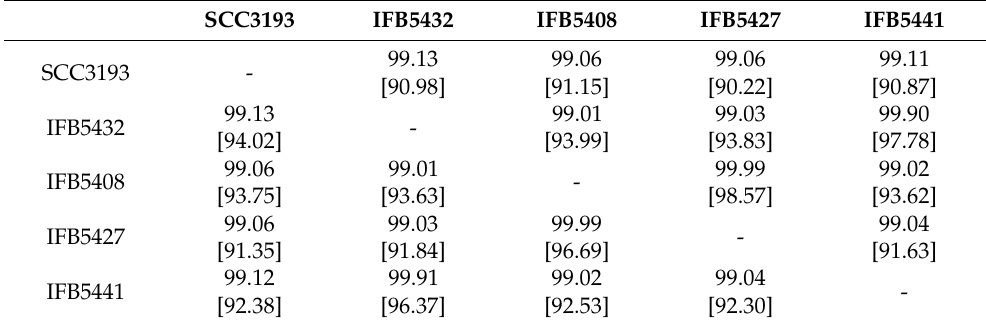
Table 3. ANIm-based pairwise genome comparisons between the studied P. parmentieri strains.